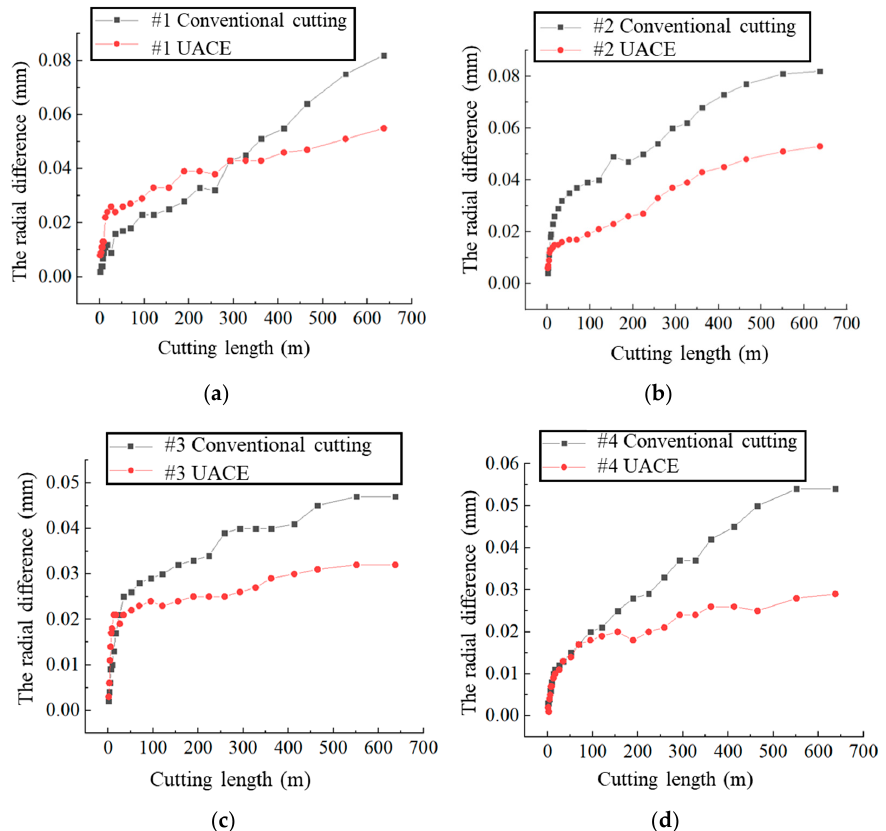
Figure 8. The radial difference of the disc cutter: ( a ) Position 1; ( b ) Position 2; ( c ) Position 3; ( d ) Position 4.